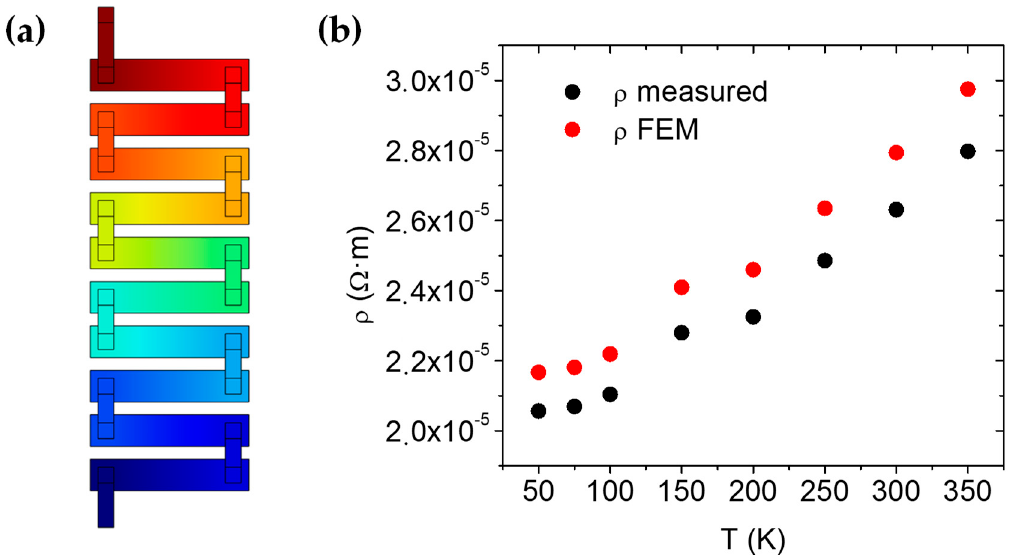
Figure 2. ( a ) Image of the voltage distribution in the modeled thermocouples. ( b ) Comparison between the measured resistivity (calculated using the distance between centers of the contacts as thermocouple length) and the modeled resistance.